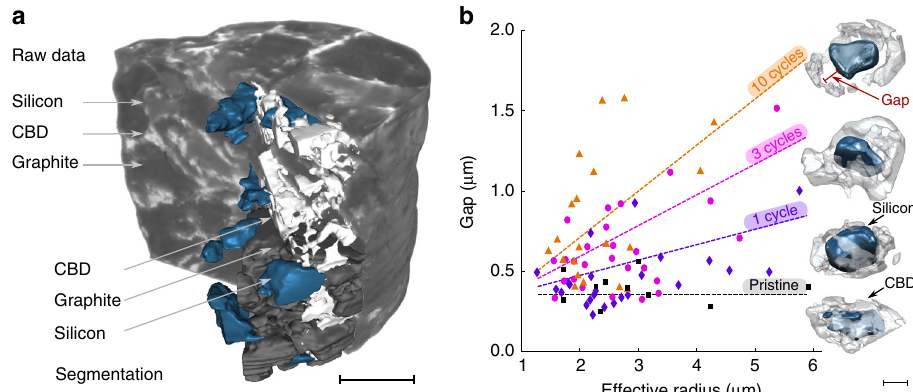
Fig. 2 Transmission X-ray tomographic microscopy. a Tomographic raw data of a pristine silicon-graphite electrode shown with multi-phase segmentation, whereby the silicon particles (blue), the graphite particles (dark gray), the carbon black-binder domain (light gray), and the pore space can be distinguished. Scale bar: 15 µ m. b Average gap between the surface of a silicon particle and the corresponding carbon black-binder domain as a function of the respective particle effective radius. The data have been acquired in electrodes in the pristine state (black squares) and in fully delithiated electrodes after one cycle (purple diamonds), after three cycles (magenta circles), and after ten cycles (orange triangles). Gaps increase with increasing cycle number and increasing silicon effective particle radius, which is con fi rmed by renderings of individual particles extracted from the segmented tomographic data. The dotted lines are included to guide the eye. Scale bar: 5 μ m